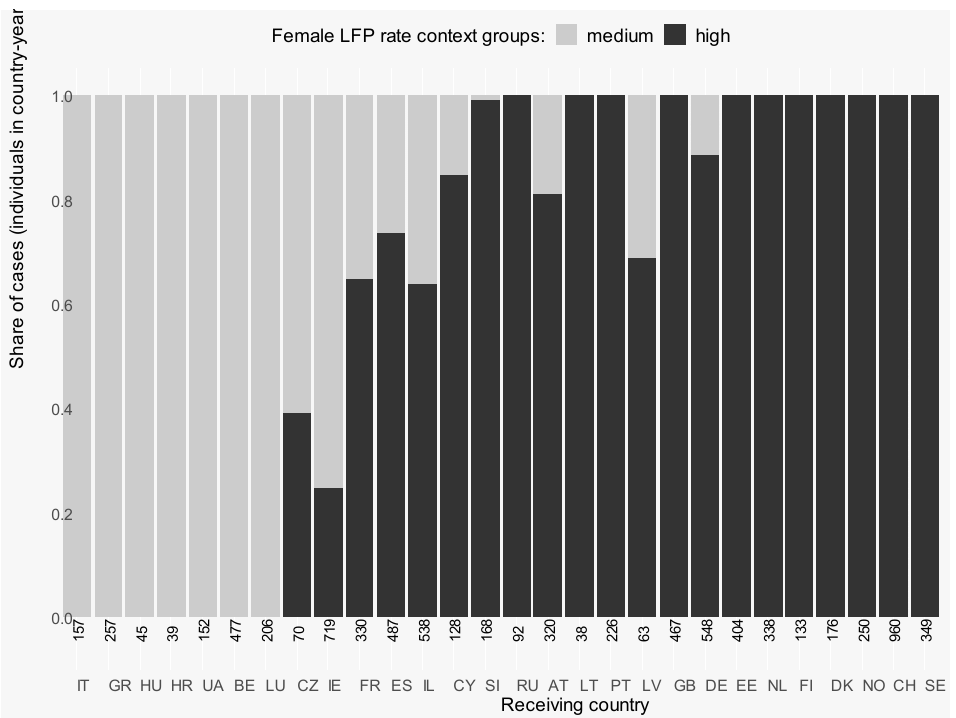
Figure 1 : Belonging to context groups of female LFP for receiving countries, 2004-2018 Female LFP rate context groups: